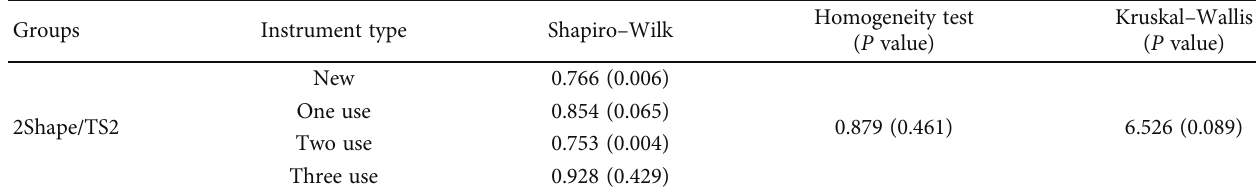
Table 4: Normality, homogeneity and Kruskal – Wallis test for 2Shape/TS2 group.